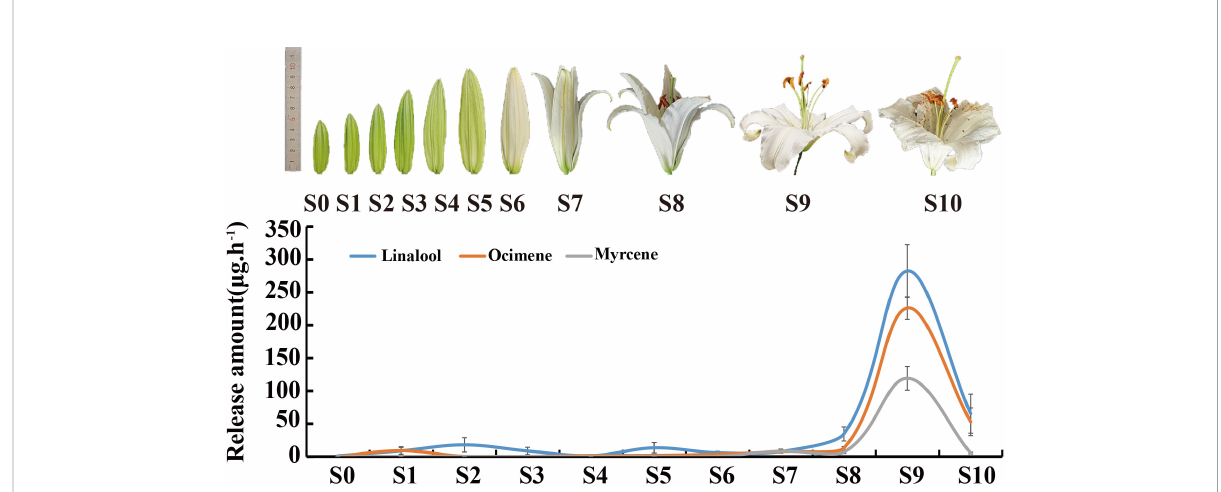
FIGURE 1 The relative release amounts of volatile components from Lilium ‘ Siberia ’ . S0-S5: 5 – 10 cm; S6: the bud color changing to white; S7: tepals splitting slightly; S8: tepals semi-opening; S9: tepals fully opened; S10: petals